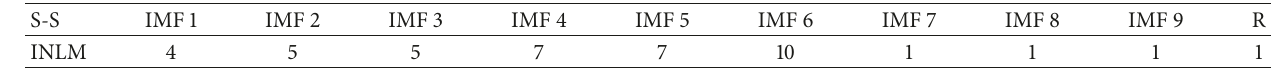
Table 2: Input numbers of the LSSVM models for each subseries (Case One).